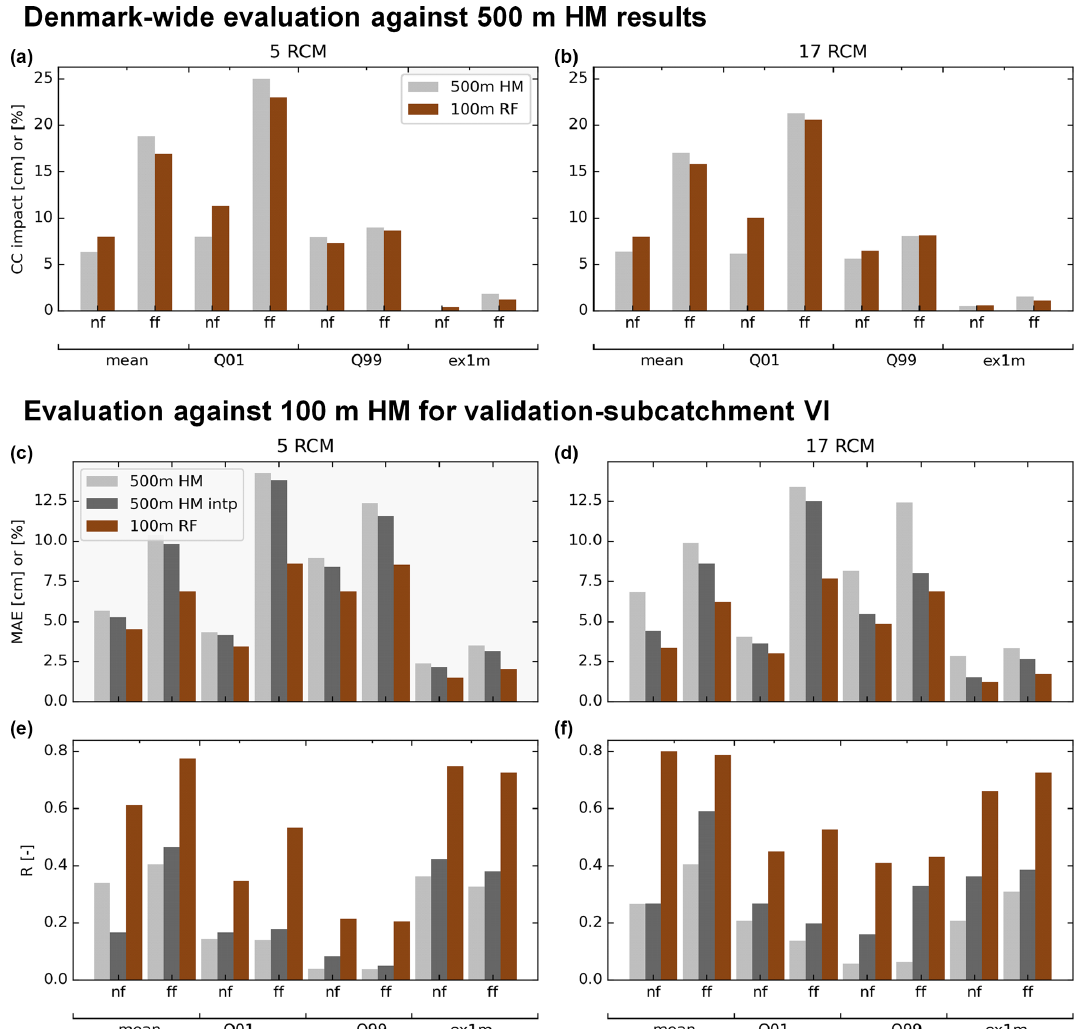
Figure 7. Overview of the validation results of the RF downscaling algorithm. (a, b) Climate change impact on the TBDV. (c, d, e, f) MAE and Pearson’s R between the 100m HM from the validation submodel and the corresponding 500m HM, both in its original resolution and using bilinear interpolation to 100m (“500m HM intp”), as well as the 100m RF results. Values along the y axis are given in cm for mean, Q 01, and Q 99, and in % for ex1m, for both near (nf, 2041–2070) and far future (ff,